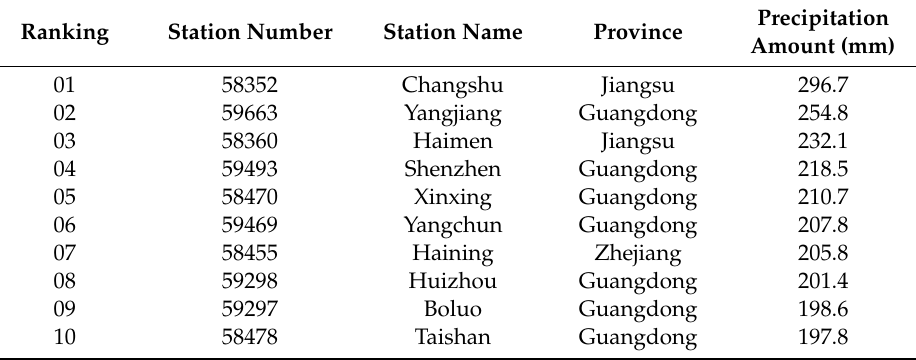
Figure 1. Observed 24-h precipitation amount (mm) during 0000 UTC 16 September to 0000 UTC 17 September 2018 and track of Typhoon Mangkhut after 11 September 2018. Locations of Guangdong (GD), Guangxi (GX), Hainan (HN), Fujian (FJ), Jiangxi (JX), Zhejiang (ZJ), Jiangsu (JS) Provinces and Shanghai (SH), Haimen, Changshu, and Taishan Cities are marked. Table 1. Top 10 stations with the largest 24-h precipitation amount during 0000 UTC 16 September to 0000 UTC 17 September